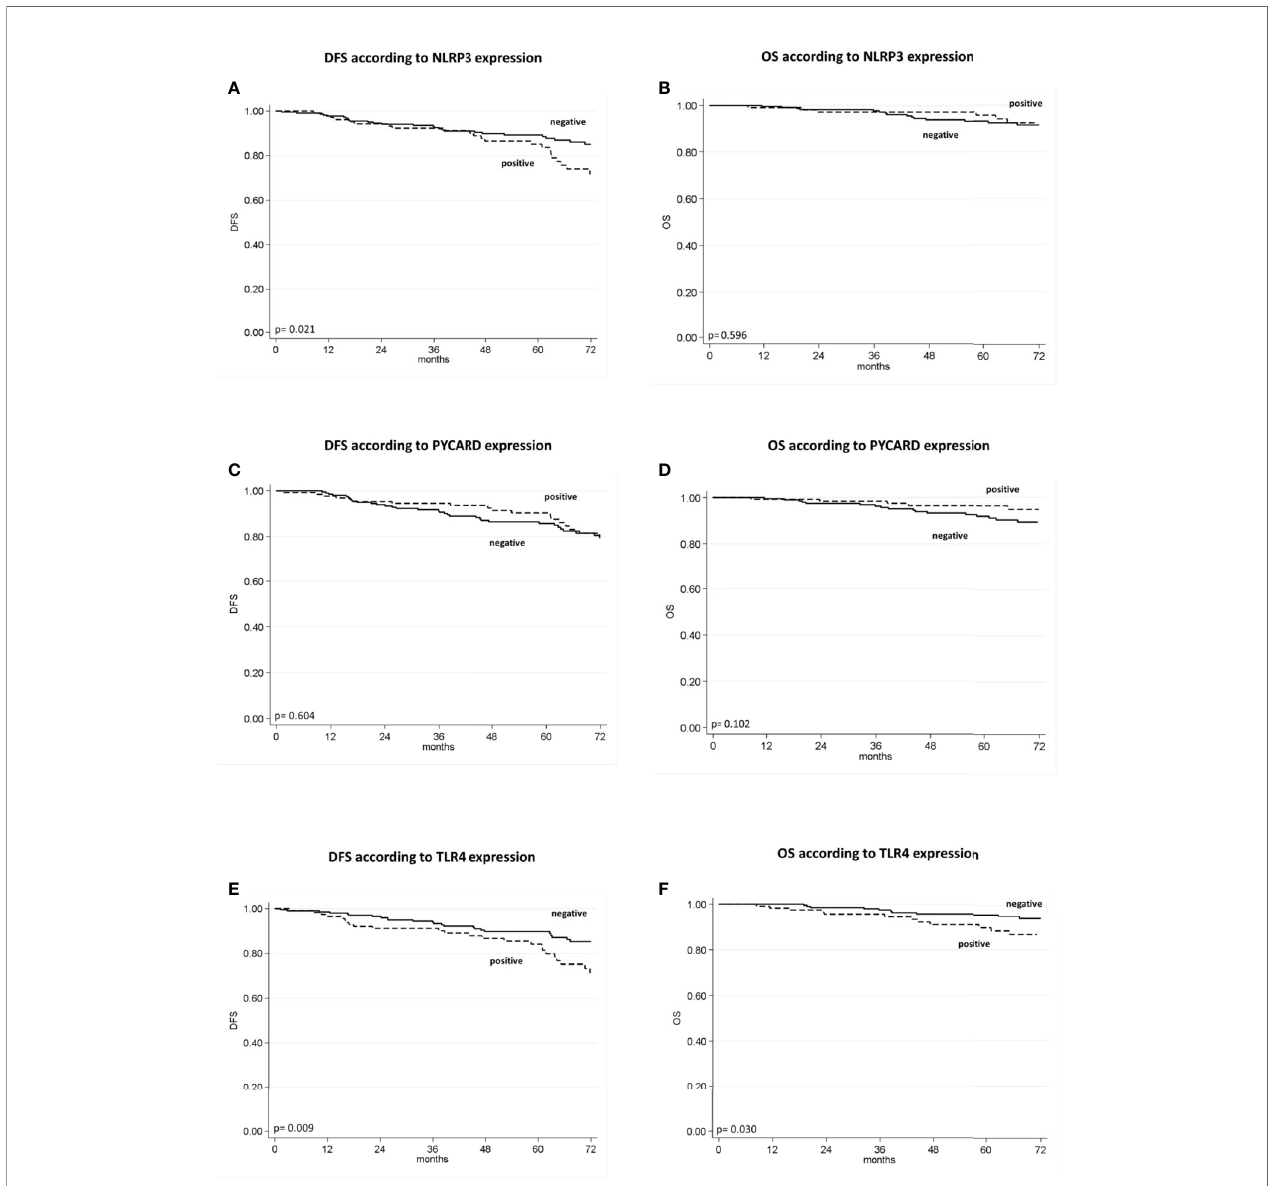
FIGURE 3 | Kaplan – Maier curve analysis and log-rank test. (A) Kaplan – Maier curve for disease-free survival (DFS) according to NLRP3 positive versus negative patients (85% vs . 89%; 95% CI, 78-92 vs 85-93; p = 0.021); (B) Kaplan – Maier curve for overall survival (OS) according to NLRP3 positive versus negative patients (96% vs . 93%; 95% CI, 92-100 vs 90-97; p = 0.596); (C) Kaplan – Maier curve for DFS according to PYCARD positive versus negative patients (90% vs . 86%; 95% CI, 81-91 vs 85-96; p=0.604; (D) Kaplan – Maier curve for OS according to PYCARD positive versus negative patients (96% vs . 92%; 95% CI, 93-100 vs 88-96; p = 0.102); (E) Kaplan – Maier curve for DFS according to TLR4 positive versus negative patients (84% vs . 90%; 95% CI, 77-91 vs 85-94; p = 0.009); (F) Kaplan – Maier curve for OS according to TLR4 positive versus negative patients (90% vs . 96%; 95% CI, 84-96 vs 93-98; p =